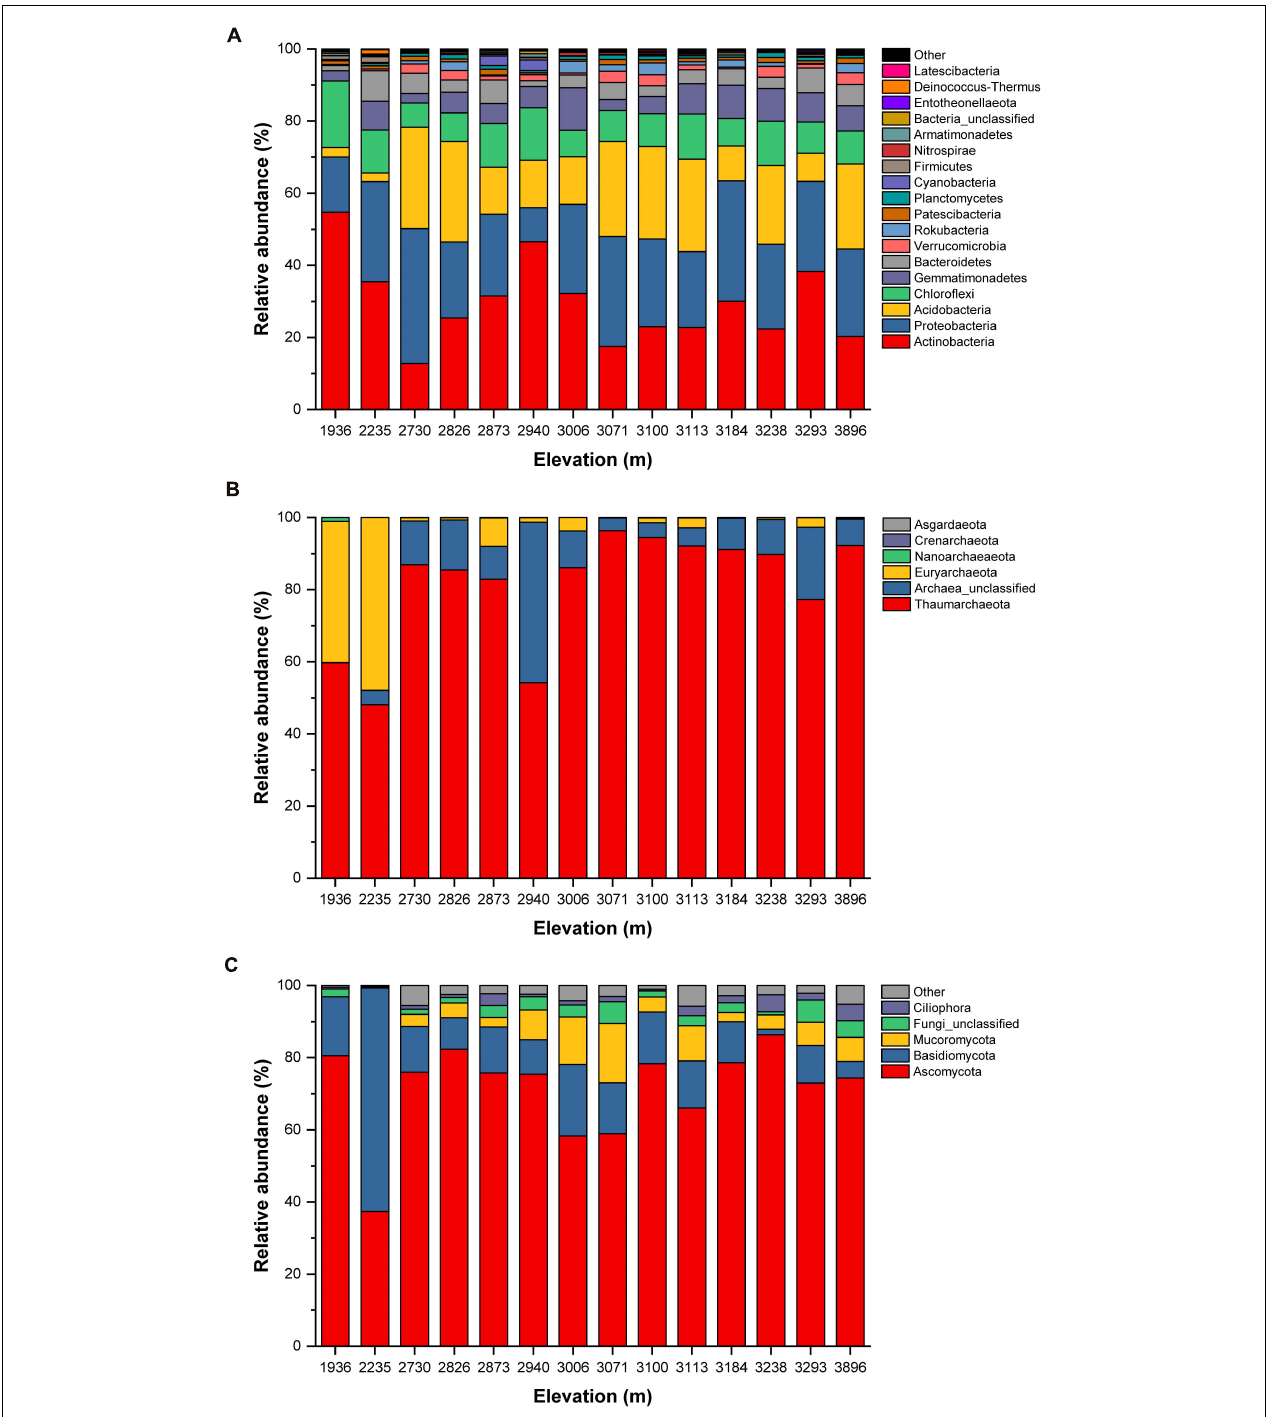
FIGURE 3 | Relative abundance (%) of the (A) bacterial, (B) archaeal, and (C) eukaryota communities at the phylum